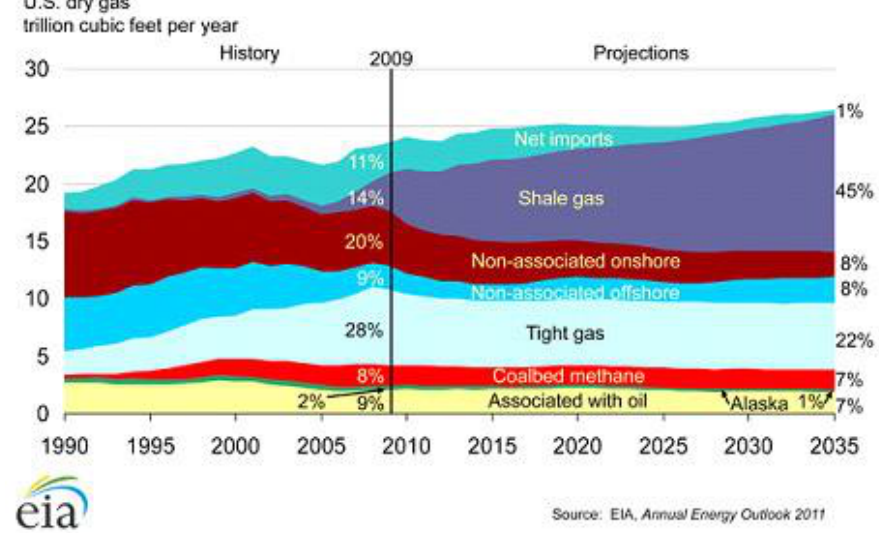
Figure 4. U.S. natural gas supply projections (1990–2035) Reproduced from U.S. Energy Figure 4 . U.S. natural gas supply projections (1990–2035) Reproduced from U.S. Energy Information